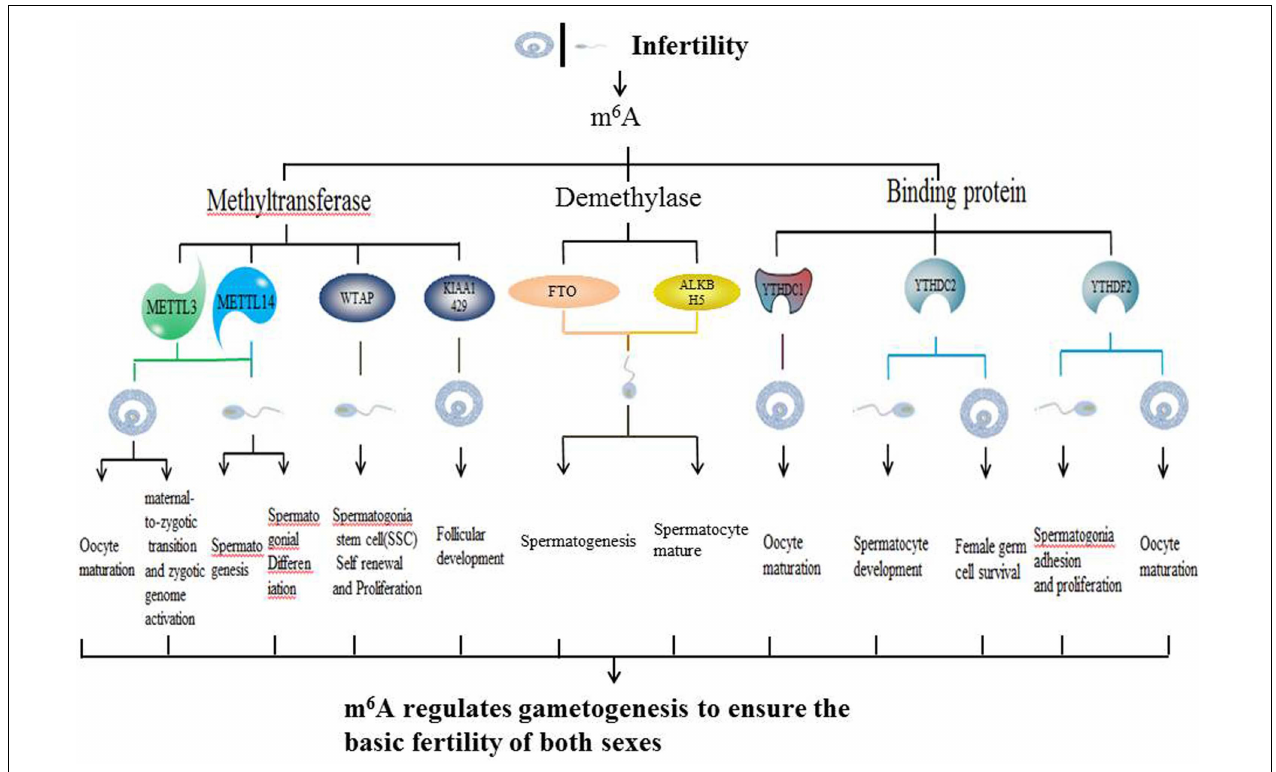
FIGURE 5 | Schematic illustration of summarizing infertility and m 6